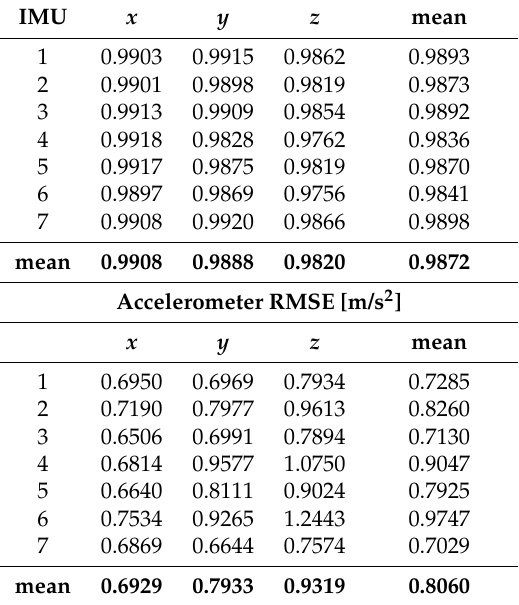
Table A2. Pearson correlation coefficients and root mean squared errors (RMSE) between real and re-simulated accelerometer data from a capturing setup where the seven IMUs used in the experiments were rigidly mounted on a rigid body and were additionally tracked with a marker based optical